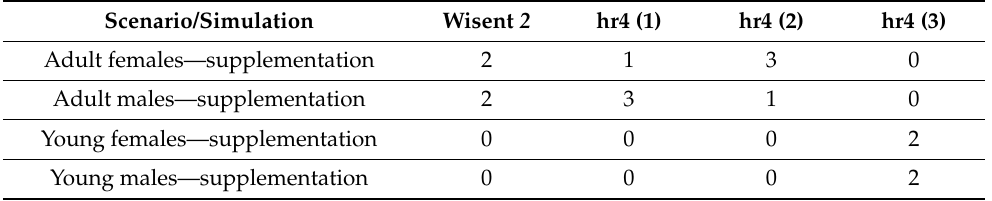
Table 3. The variables used for hr4 simulations associated with the wisent 2